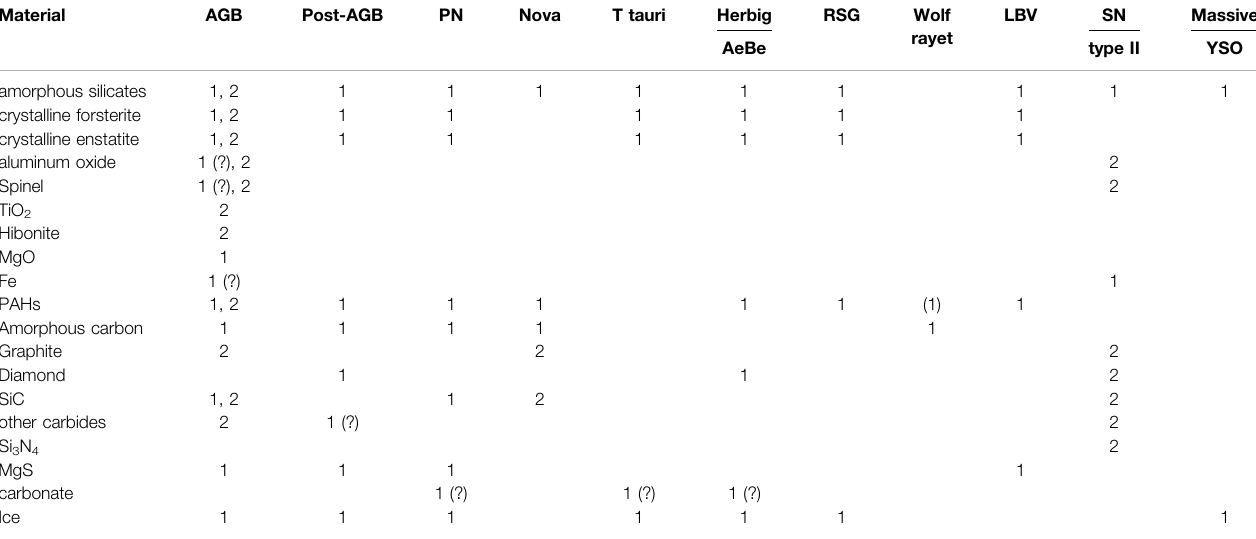
TABLE 1 | An inventory of circumstellar dust. Material